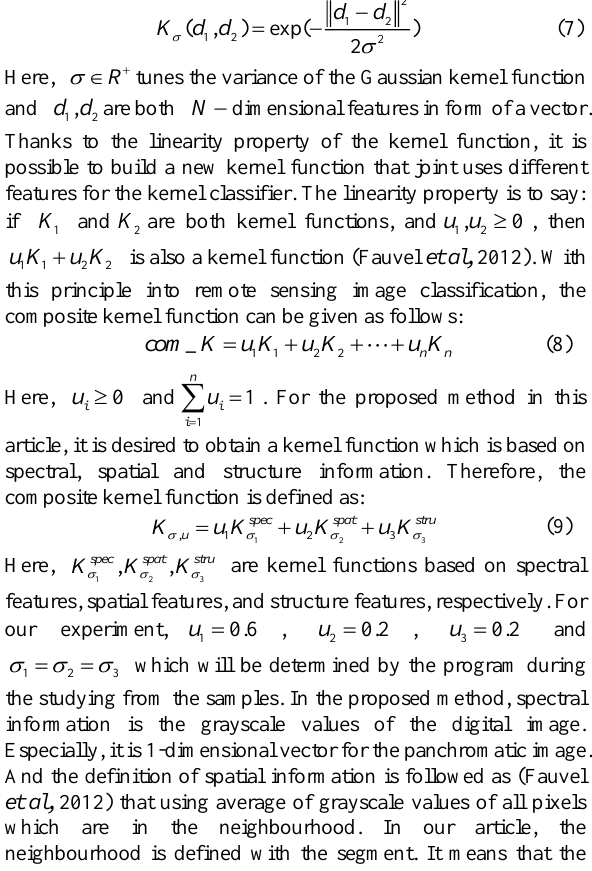
Table 1. The parameter